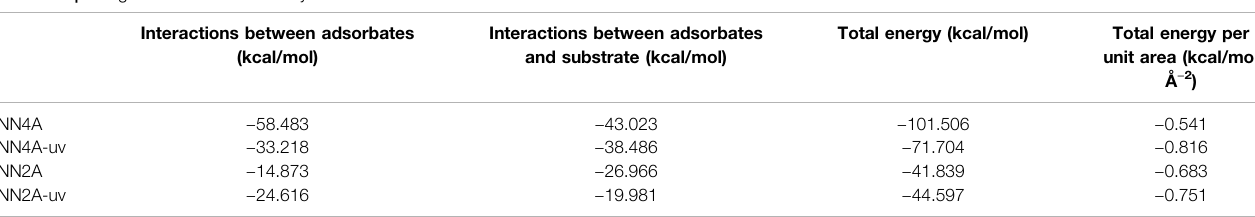
TABLE 2 | Energies of self-assembled systems on the HOPG surface. a Interactions between adsorbates Interactions between adsorbates (kcal/mol) and substrate (kcal/mol)